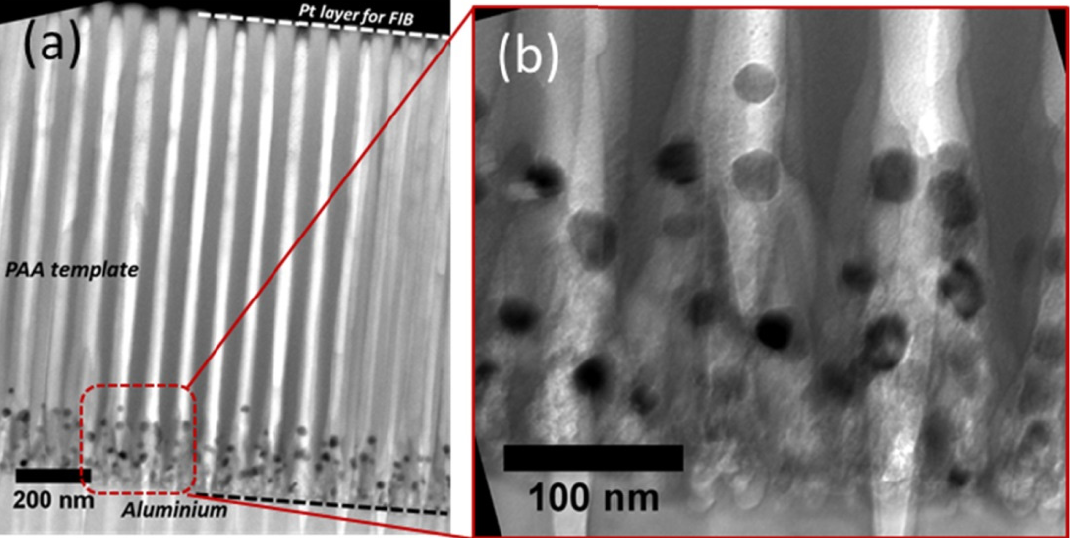
Figure 19. TEM observation of the FIB cross-section lamella of a PAA template with an average of 6 NBPP where synthesis of the CNT was carried out: ( a ) a low magnification TEM image showing the whole porous structure with the NP localized at the branched zone. ( b ) Magnification on an area of the bottom pores evidencing CNTs couldn’t evolve through the PAA template. Reprinted with permission from Ref. [83]. IOP Science Copyright © 2023.